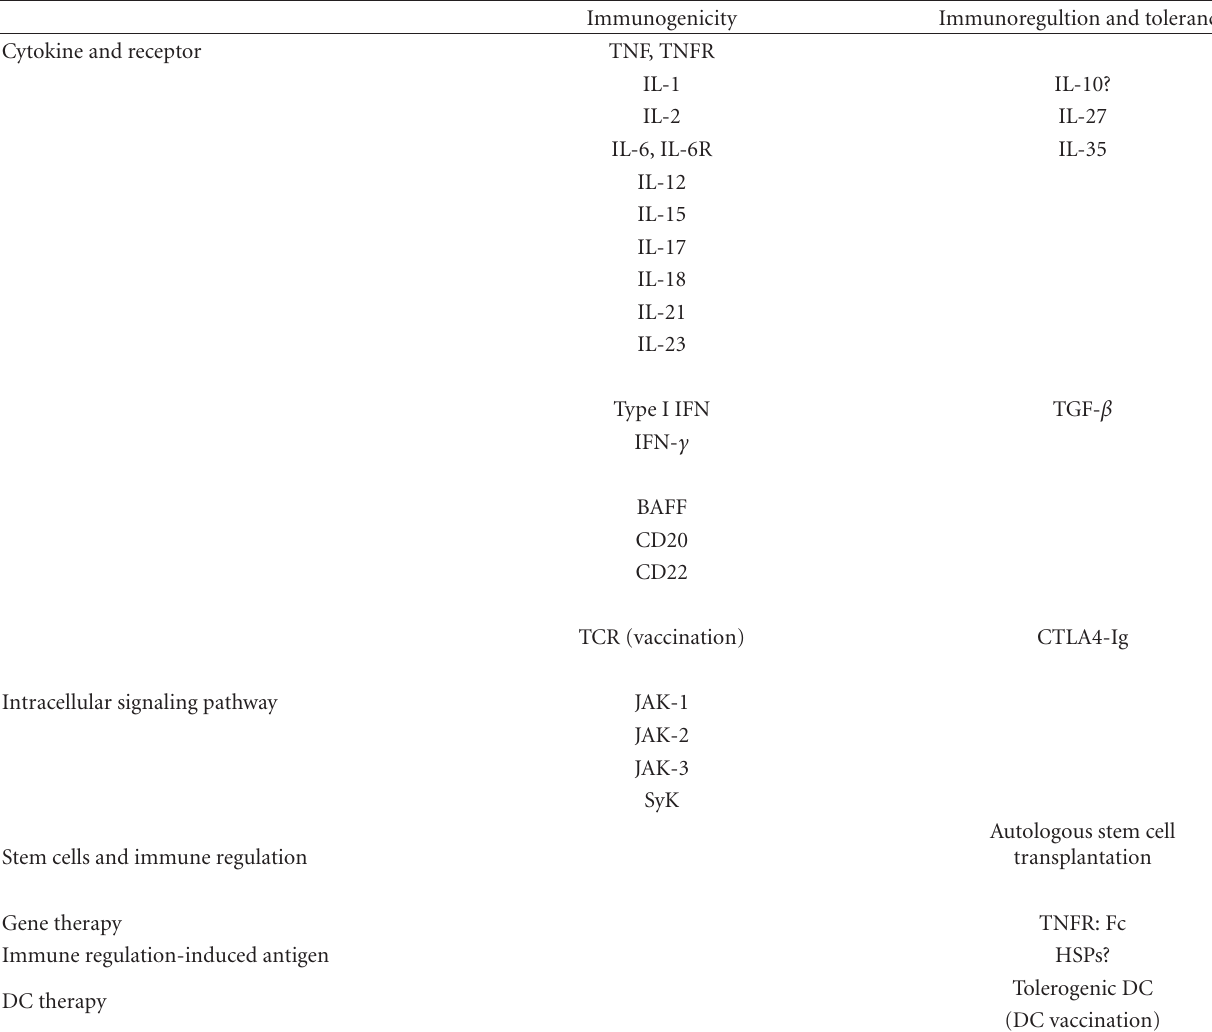
Table 1: Potential treatment options for SAIRDs